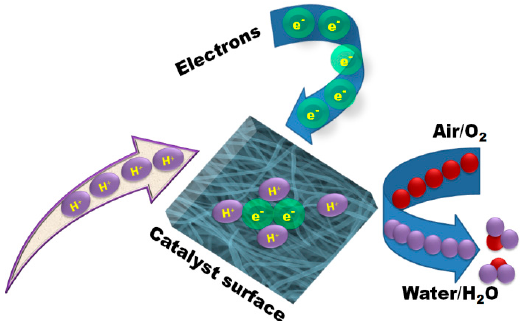
Figure 7. Schematic illustration of the proposed ORR mechanism at the C/NiCo 2 O 4 catalyst highlights